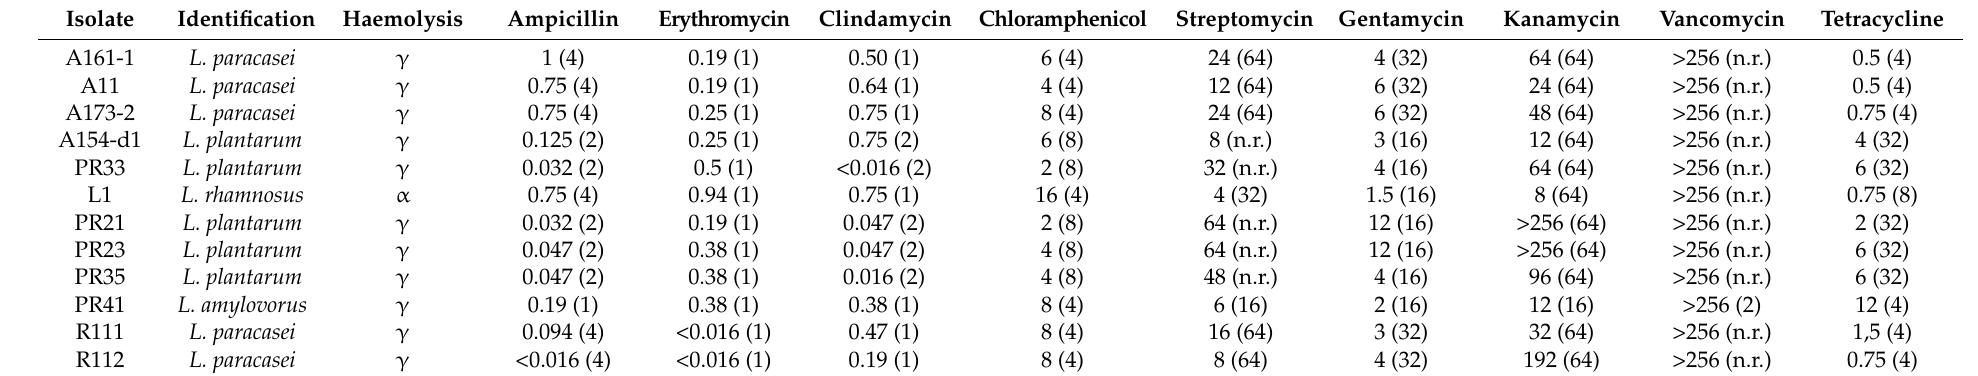
Table 1. Haemolysis and antibiotic susceptibility of lactobacilli